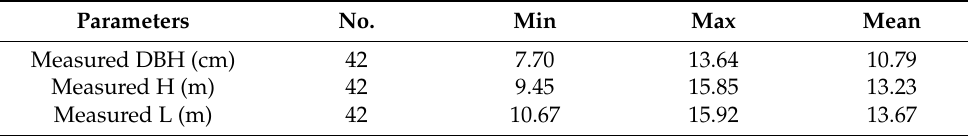
Table 1. Statistics of the measured DBHs, Hs, and Ls of individual Moso